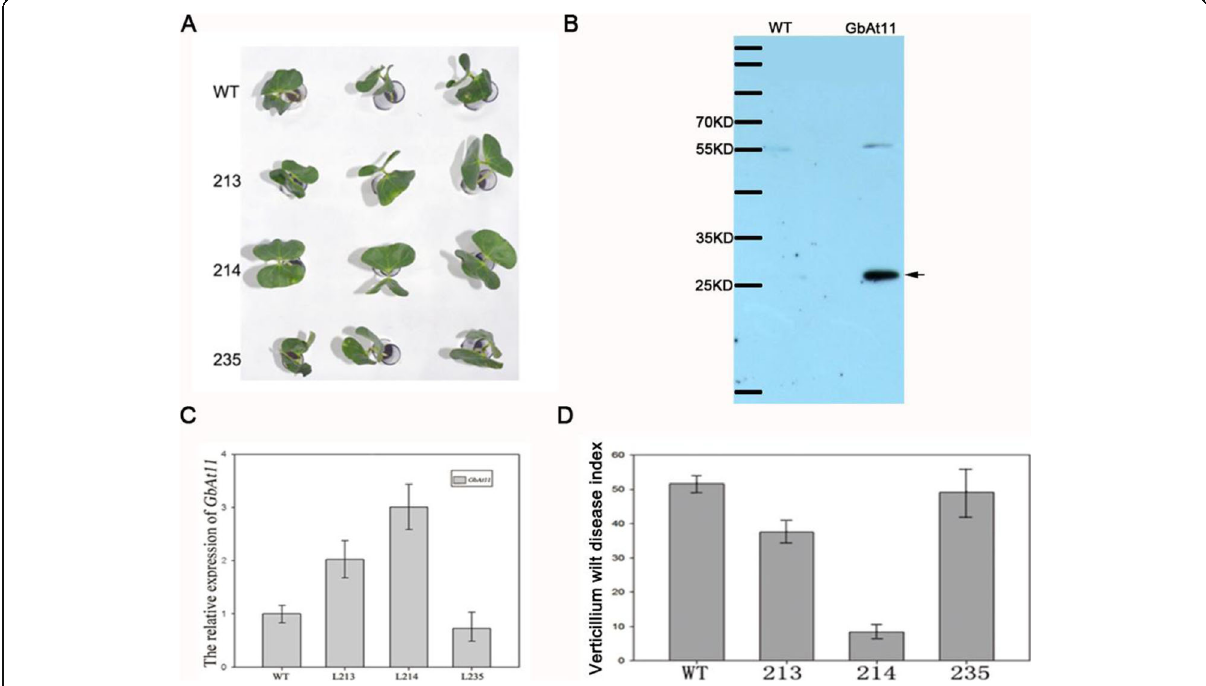
Fig. 2 The correspondence between the expression of GbAt11 and disease resistance. a Leaf phenotypes of three transgenic plants overexpressing GbAt11 and the wild type (WT, G. hirsutum JM169) after treated with Vd991 spore suspension (1 × 10 6 per mL) for 24 h. b Flag tagged GbAT11 protein were detected by Western blot with an anti-flag antibody. c Relative expression of GbAt11 gene in indicated plants after treated with Vd991 spore suspension (1 × 10 6 per mL) for 24 h. d Quantitative statistics of disease index in three GbAt11 overexpression lines and JM169 line treated with Vd991 spore suspension (1 × 10 6 per mL) for 24